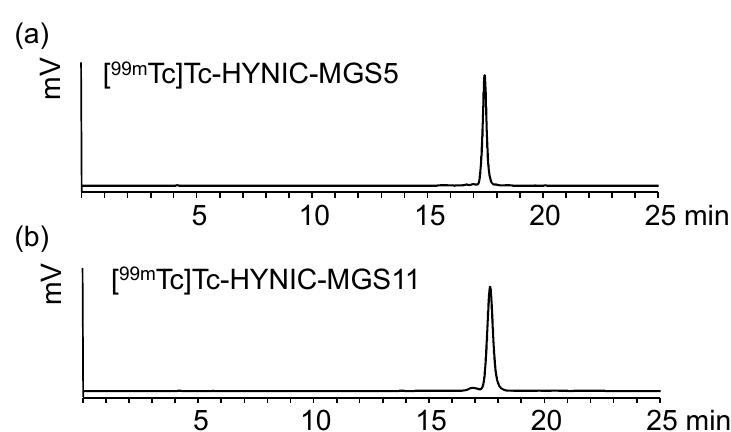
Figure 2. Radiochromatograms of ( a ) [ 99m Tc]Tc ‐ HYNIC ‐ MGS5 and ( b ) [ 99m Tc]Tc ‐ HYNIC ‐ MGS11.